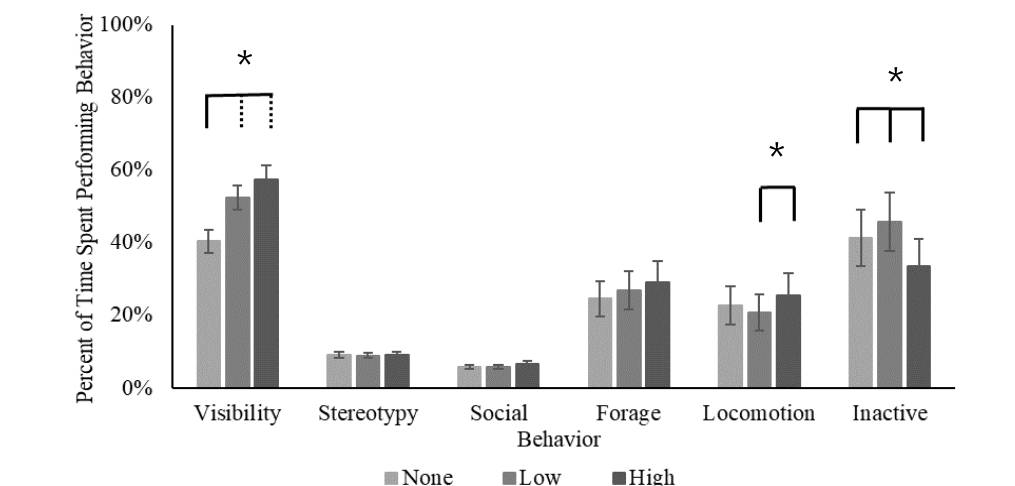
Mean Percentage of Time Spent in Behaviors across Crowd